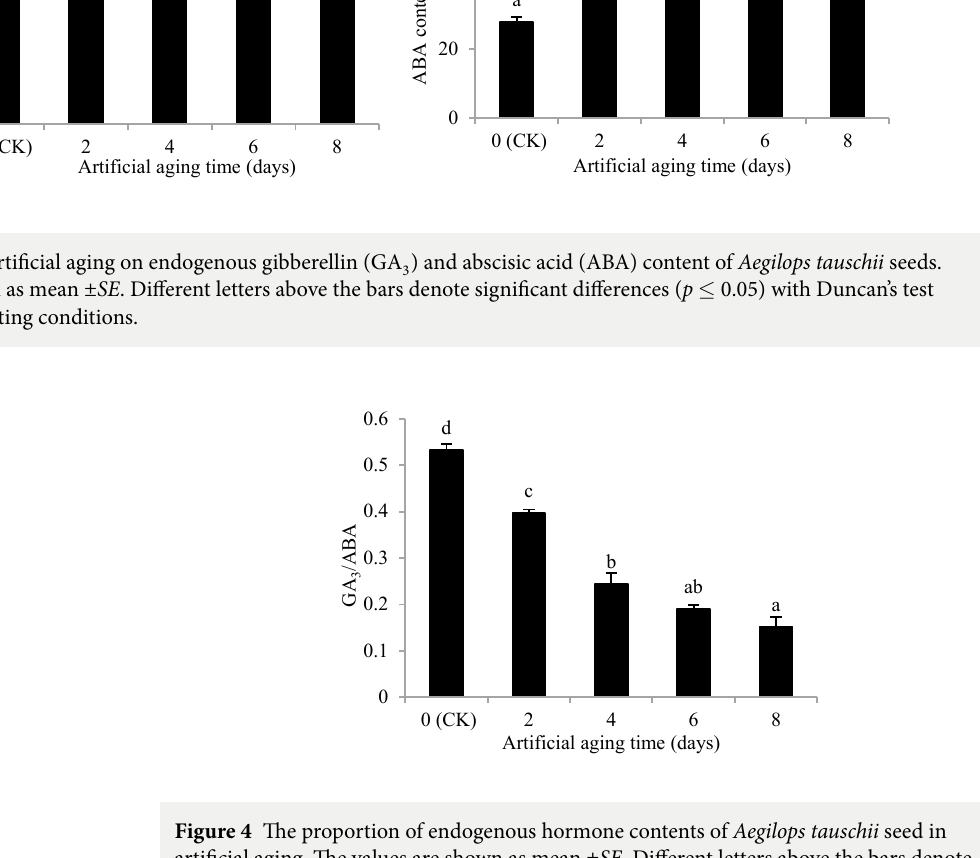
Figure 4 e proportion of endogenous hormone contents of Aegilops tauschii seed in artificial aging. e values are shown as mean ± SE . Different letters above the bars denote significant differences ( p ≤ 0.05) with Duncan’s test within the same planting